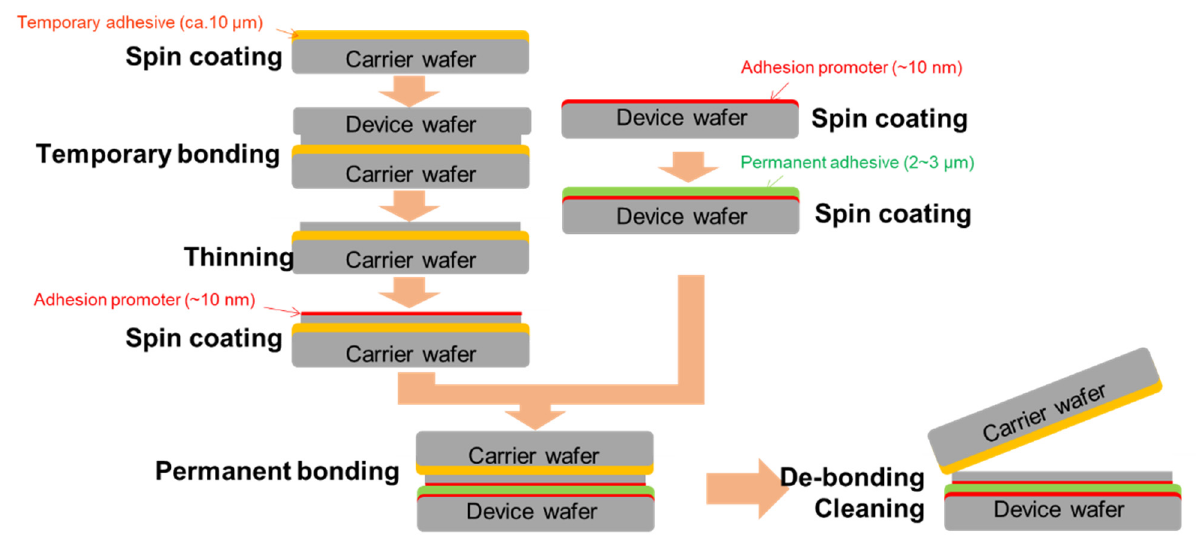
Figure 10. Process flow to evaluate temporary and permanent adhesives for design of experiment (DOE) of wafer stacking. Table 1. Properties and process conditions.